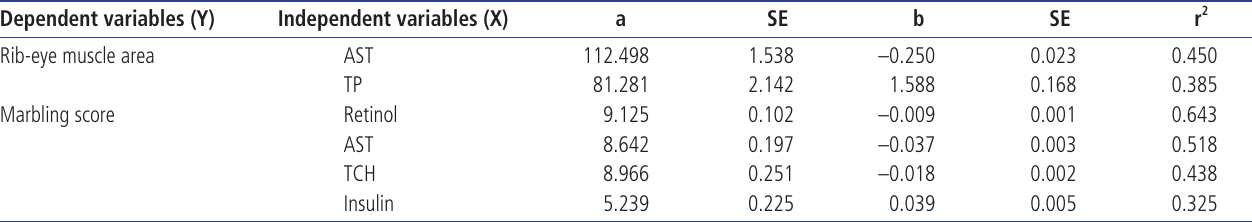
Table 5. The regression equations (Y = a+bX) between blood components and carcass traits in Hanwoo steers Dependent variables